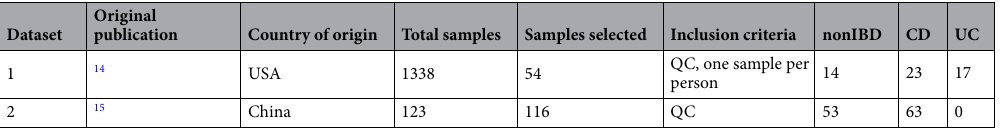
Table 4. MEDIC Challenge training datasets.